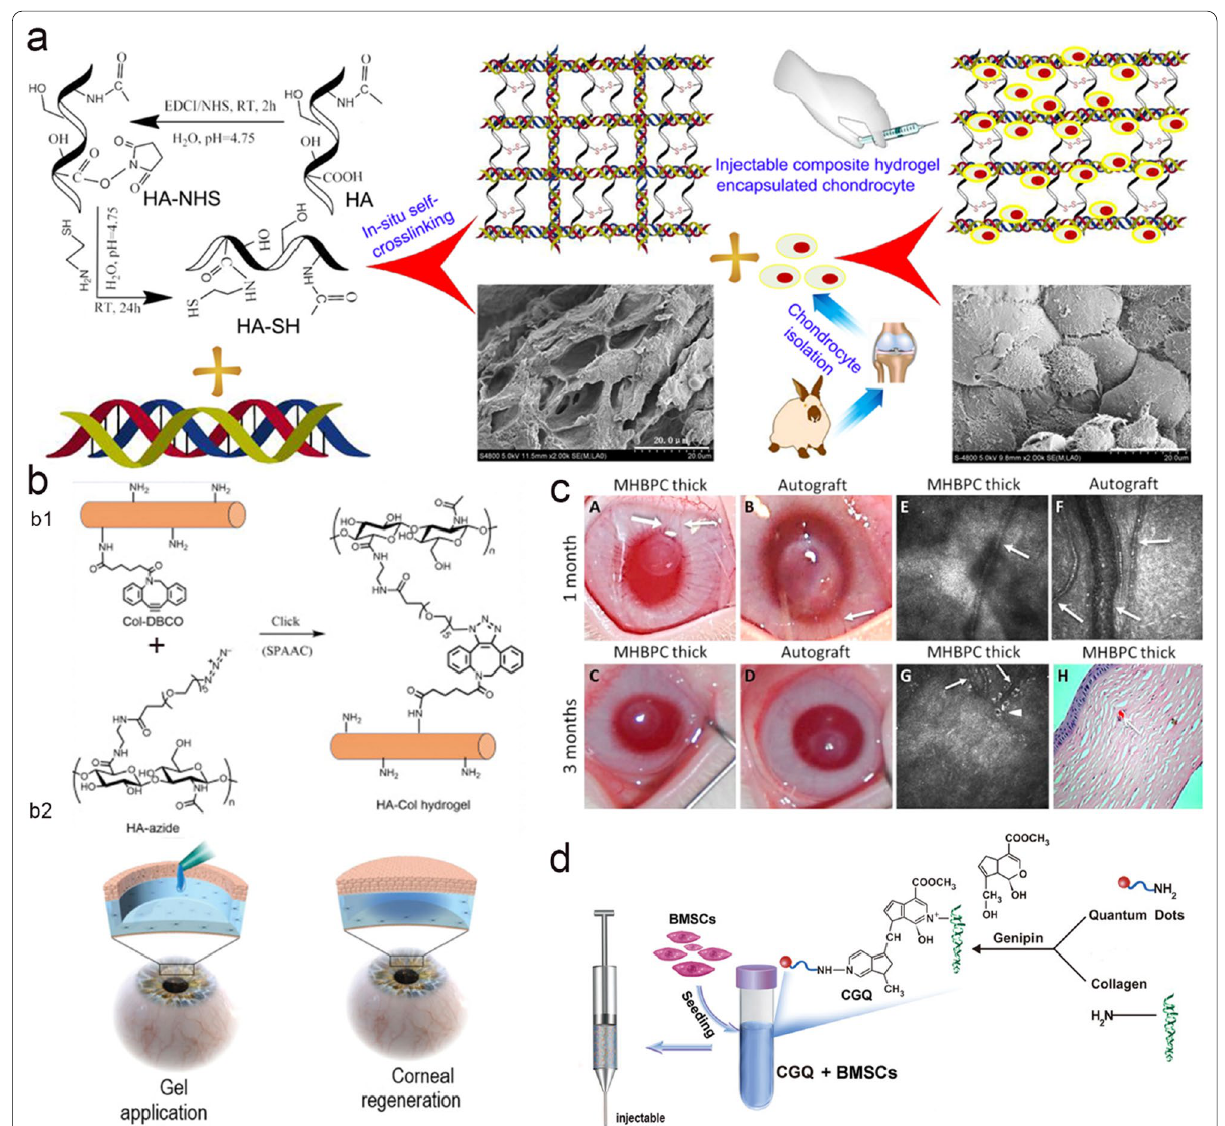
Fig. 4 Application of collagen-based blends. a An injectable self-cross-linking HA-SH/Col I blend hydrogels for in vitro construction of engineered cartilage. Reproduced with permission from [88]; b Application of hydrogel for sutureless repair of corneal wounds: ( b1 ) Hyaluronate-collagen hydrogel cross-linked via strain-promoted azide-alkyne cycloaddition (SPAAC); ( b2 ) Sutureless repair of corneal wounds. Reproduced with permission from [89]; c Postoperative neovascularization in a collagen-based composite hydrogel as implants and autograft corneas. Reproduced with permission from [90]; d The fabrication process of collagen–genipin–quantum dot (CGQ) composite hydrogels. Reproduced with